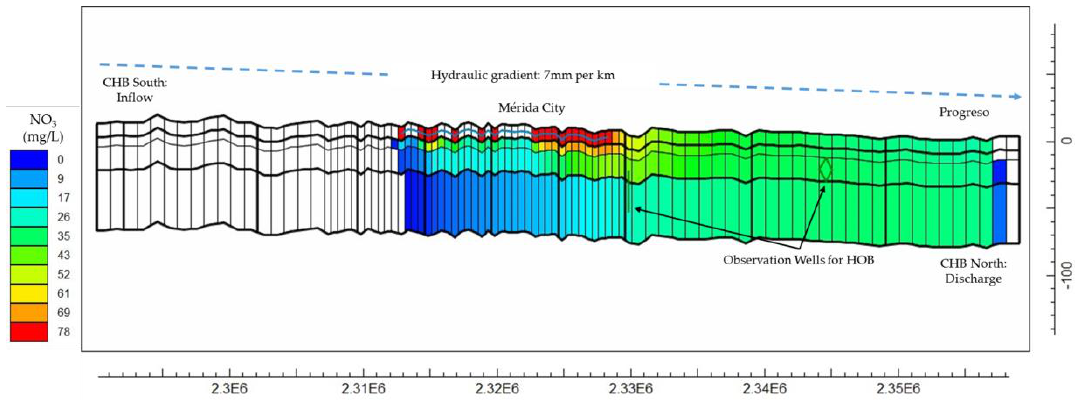
Figure 8. Behavior of the pollution plume under Merida City. The pollution travels towards the coast north of the city, increasing its concentration in layer 2 and 3.